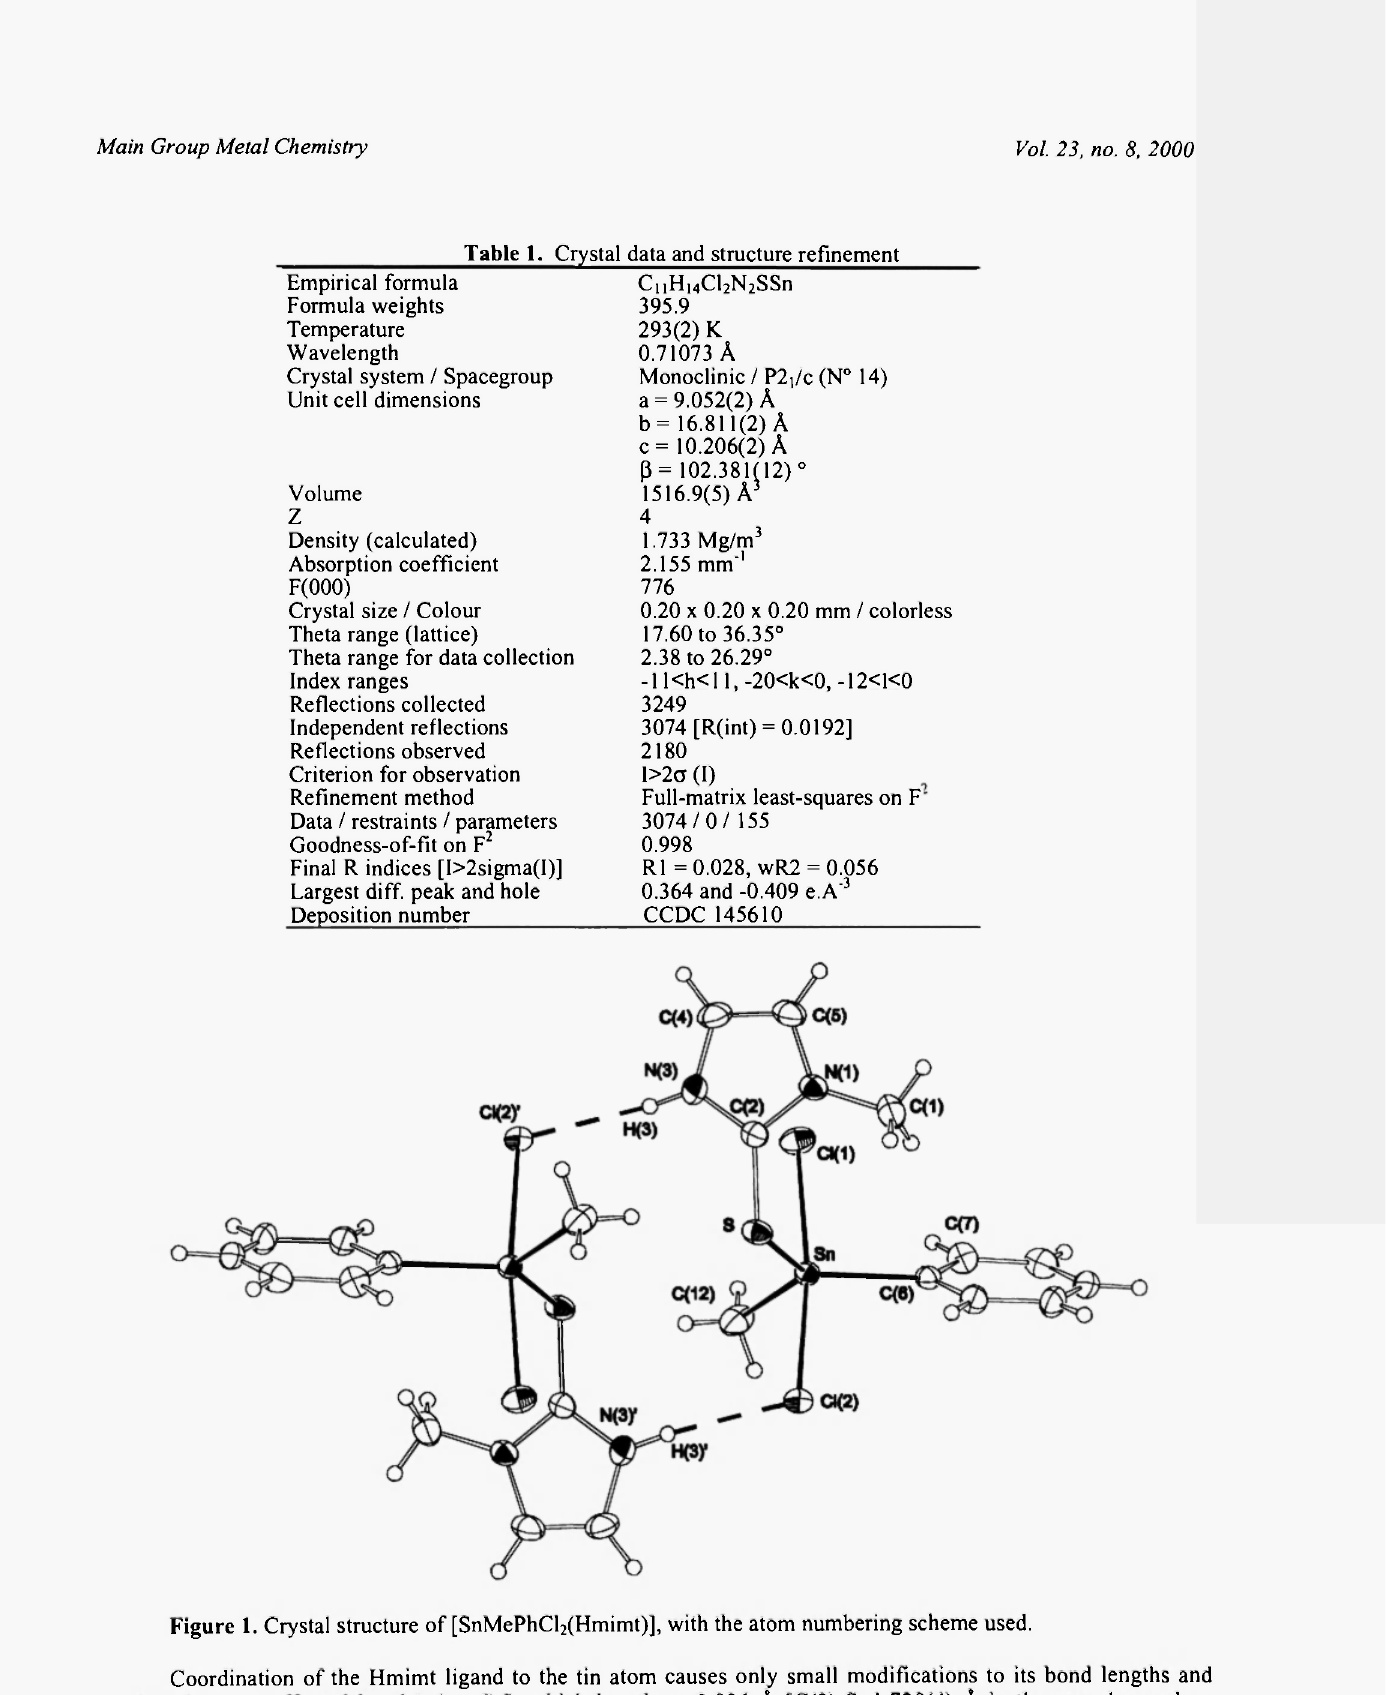
Figure 1. Crystal structure of [SnMePhCl 2 (Hmimt)], with the atom numbering scheme used. Coordination of the Hmimt ligand to the tin atom causes only small modifications to its bond lengths and angles, the most affected bond being C-S, which lengthens 0.036 A [C(2)-S=l.720(4) Ä in the complex and an average 1.684(2) A in the free ligand 25 ]. The significant differences observed among the Sn-S bond lengths